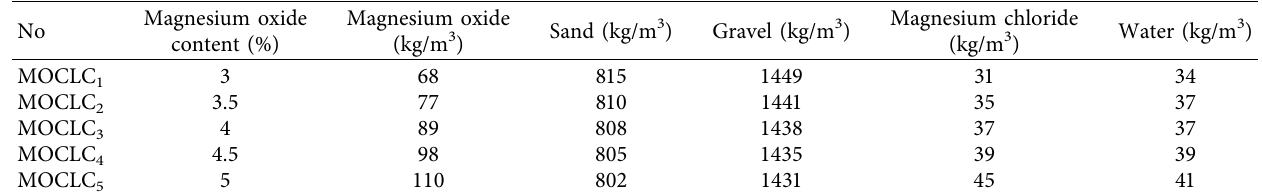
Table 5: Mixing proportions of MOCLC.